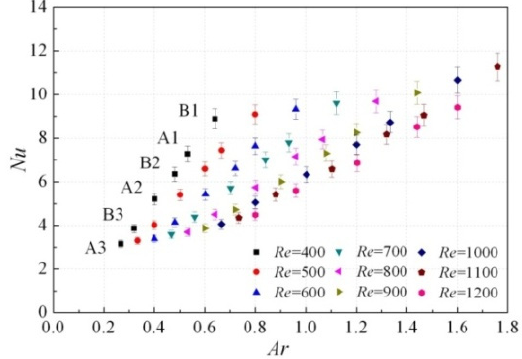
Figure 8. Nusselt number variation with A r , Va = 150.